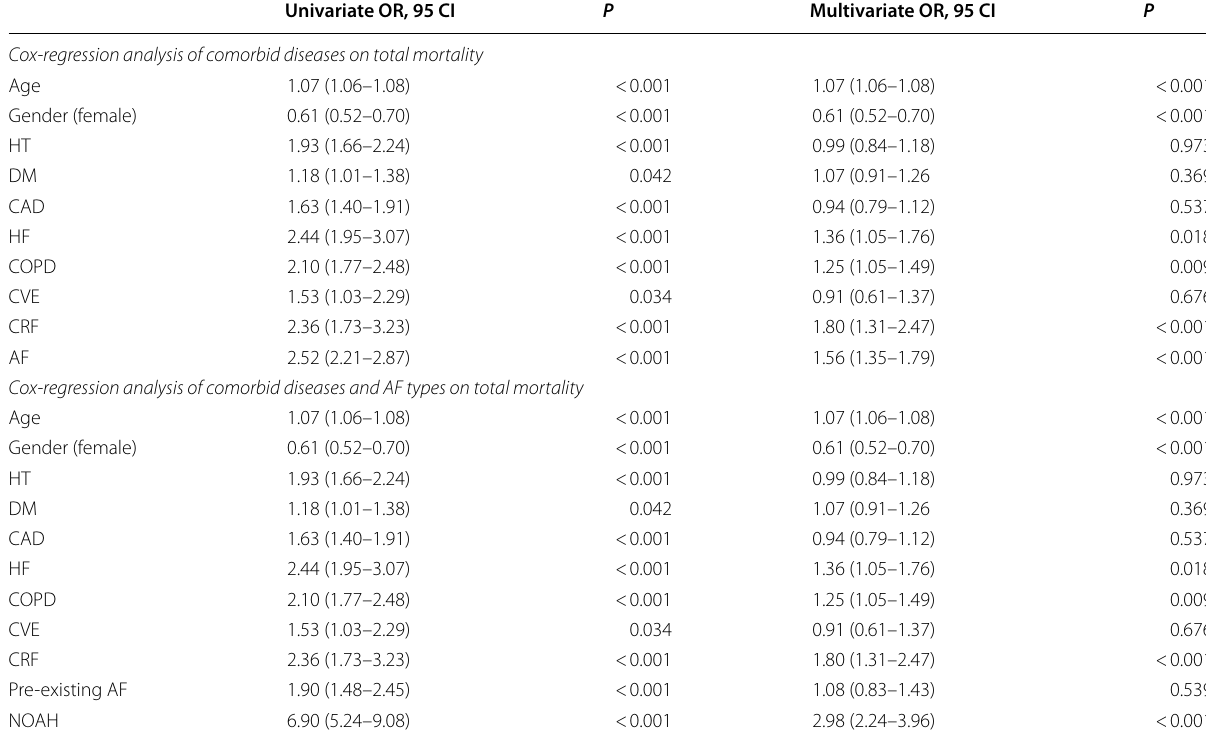
Table 3 Cox-regression analysis on total